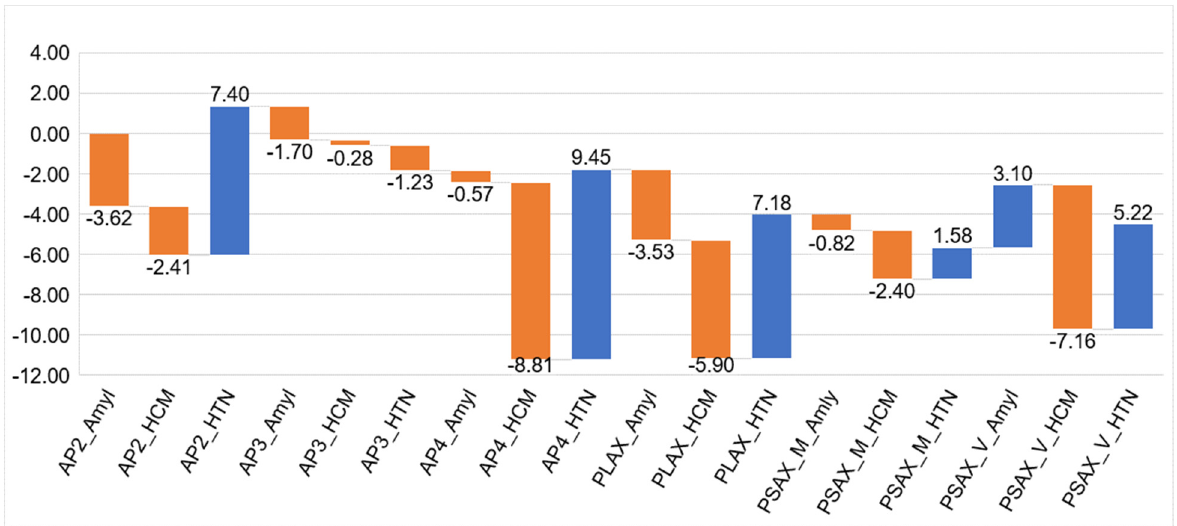
Figure 7. The coefficients of the meta learner for the final decision. Each model has three output channel which correspond to the three classes. Apical 2-chamber (AP2), 4-chamber (AP4), and parasternal long-axis (PLAX) views had more contributions to the final decision of the HTN/other class. Apical 4-chamber view (AP4), parasternal short- (PSAX, mid LV level) and long-axis views were more informative for the class of HCM. For cardiac amyloidosis, apical 2 chamber (AP2), parasternal long axis and parasternal short axis (mid LV level) were more informative.